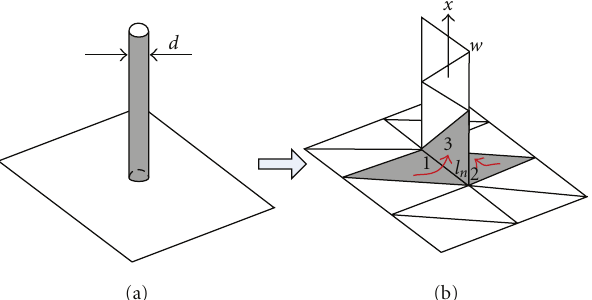
Figure 1: A strip model in the excitation source of antenna. (a) Wire-surface junction. (b) Surface-surface junction model.